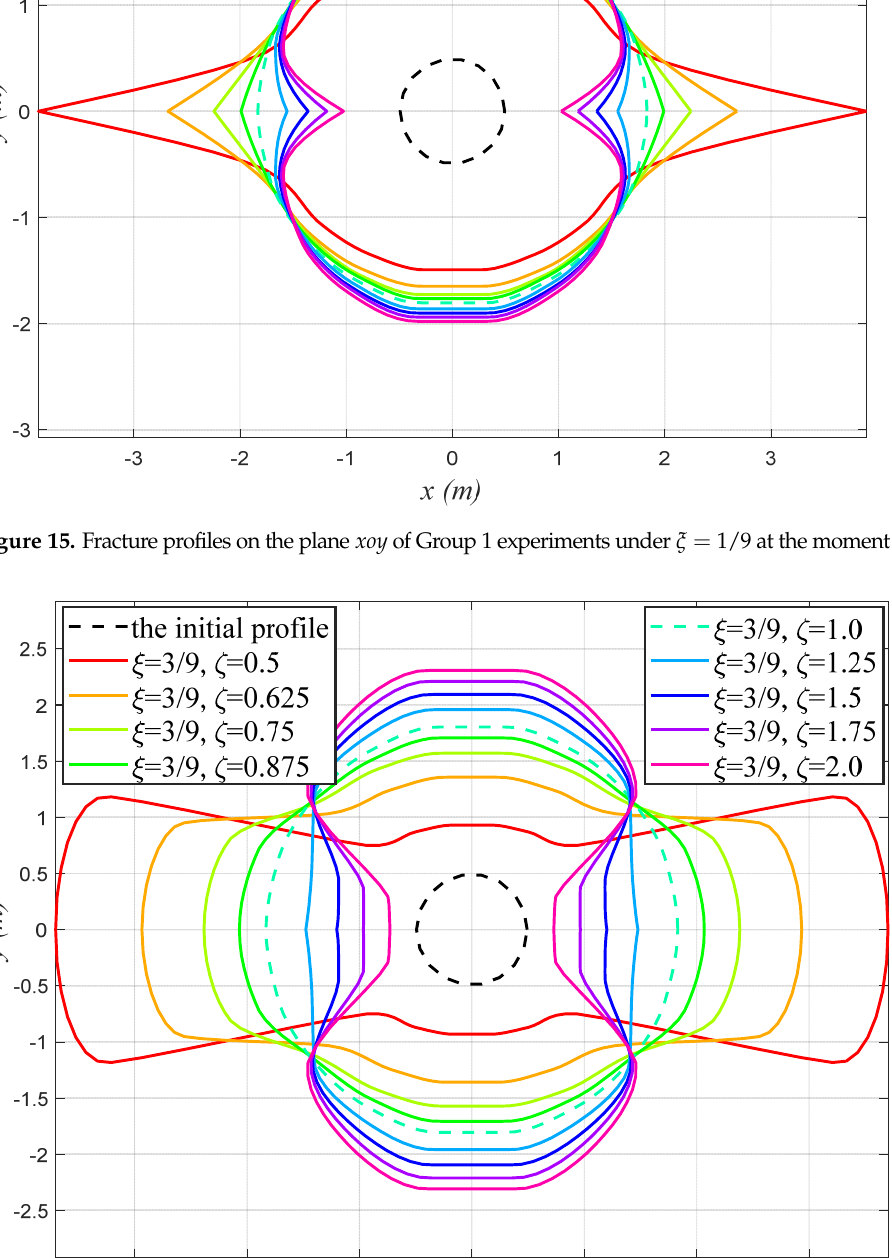
Figure 17. Fracture profiles on the plane 𝑥𝑜𝑦 of Group 3 experiments under 𝜉 = 5 9⁄ at the mo- ment = 20 s .